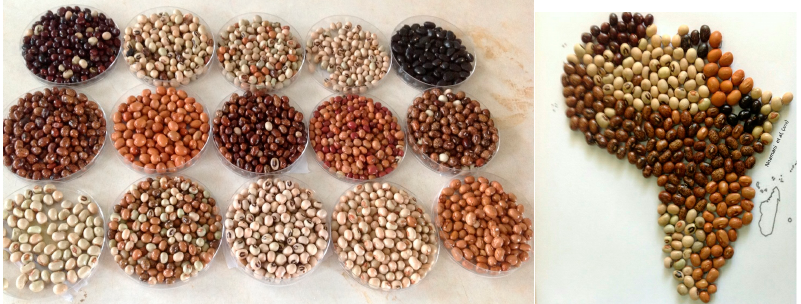
Figure 5. Diversity in seed coat colours and patterns in Sphenostylis stenocarpa ( e x. A. Rich.) Harms. (African yam bean) accessions from five states in southeast, Nigeria. Photo by Nnamani.